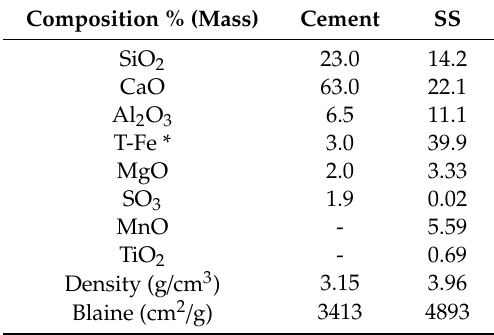
Table 2. Chemical compositions and physical properties of